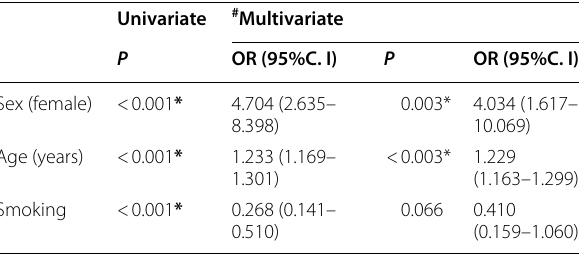
Table 6 Univariate and multivariate analysis for the parameters